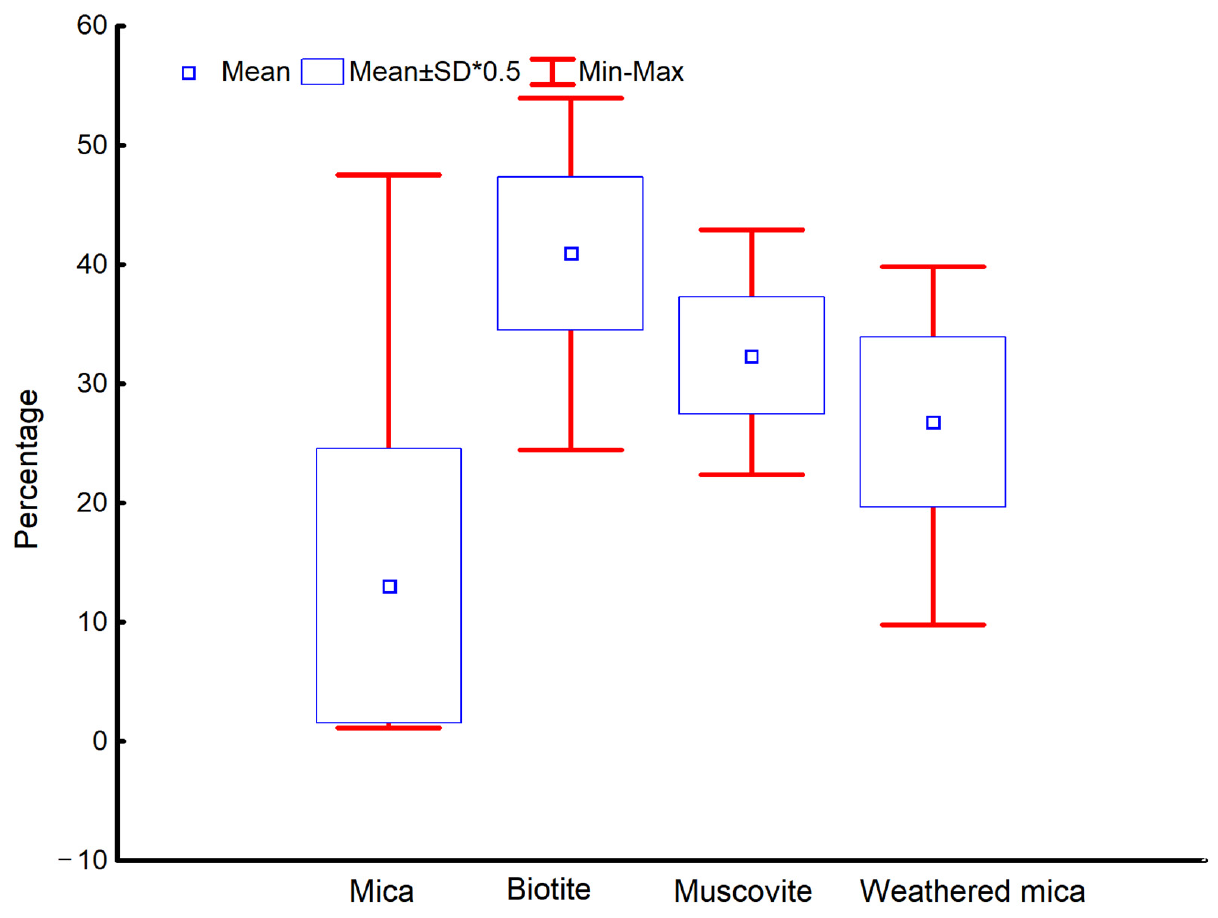
Figure 4. Mass percentage of mica, particle percentages of biotite, weathered mica and muscovite in the very fine sand fraction of ancient Yellow River Estuary sediments (mass percentage of mica = 100 * total mica mass/total mineral mass. Particle percentage of biotite or weathered mica or muscovite = 100 * particle number of biotite or weathered mica or muscovite/total particle number of mica).